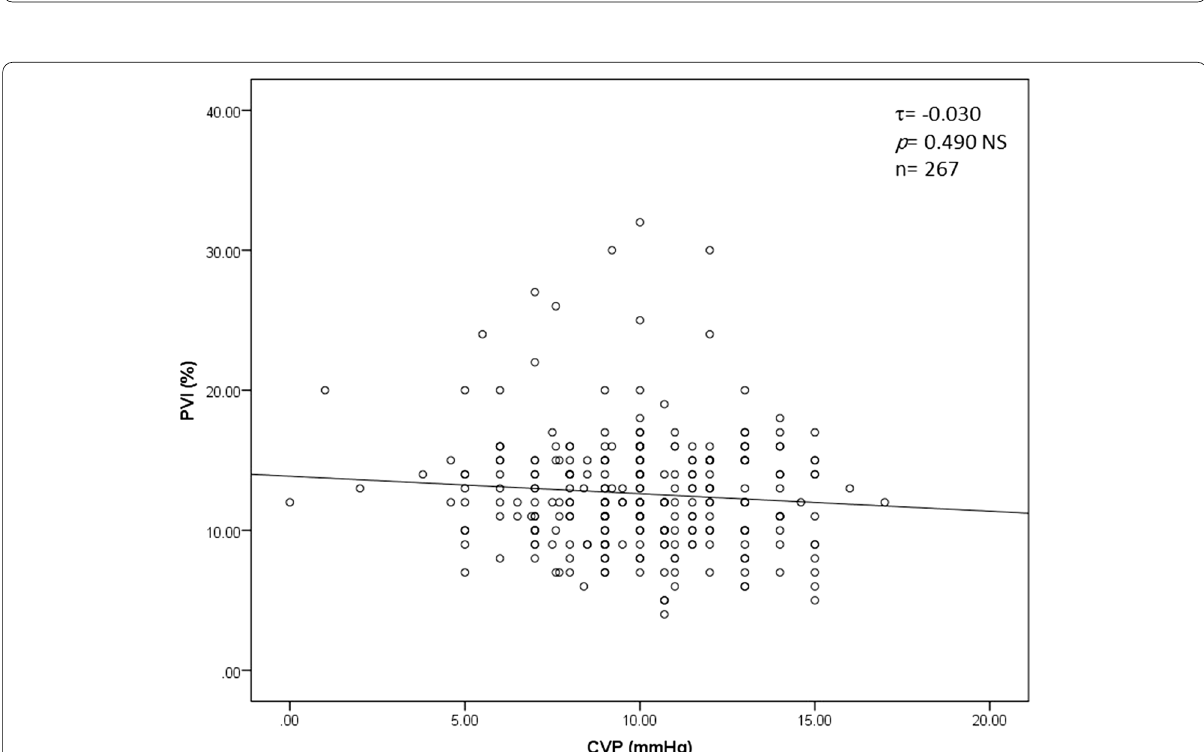
Fig. 4 Simple scatter plot with regression (best fit) line and correlation between pleth variability index (PVI, %) and central venous pressure (CVP,